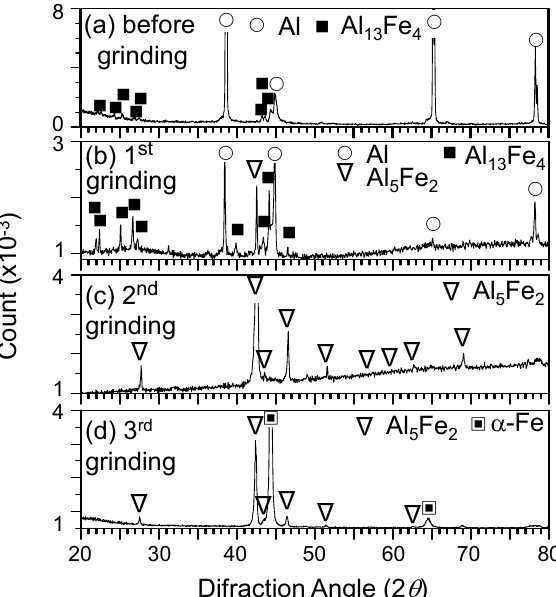
Figure 1. XRD patterns of the Al hot ‐ dipped P91 steel: ( a ) before grinding; ( b ) after first grinding; ( c ) after second grinding; ( d ) after third grinding.